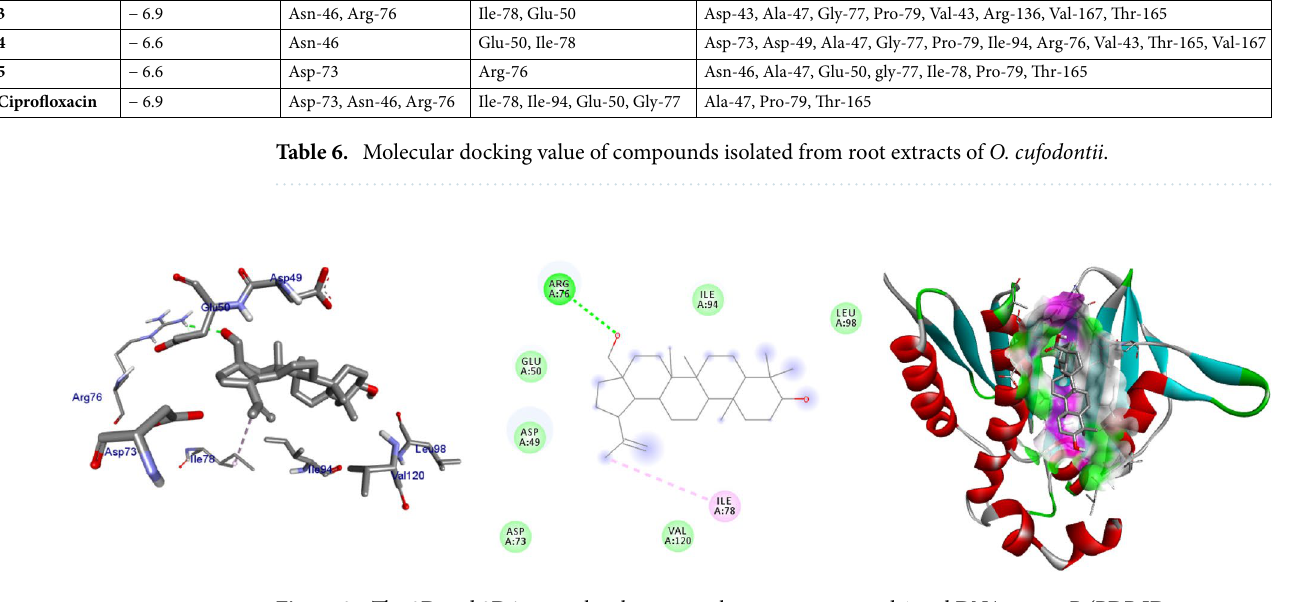
Figure 2. The 2D and 3D intermolecular contact between compound 1 and DNA gyrase B (PDB ID: 6F86). Chemical structures were drawn by ChemDraw Pro 16.0 Suite (PerkinElmer, USA) and analyzed by the Discovery studio visualizer (BIOVIA Discovery studio 2020 Client).